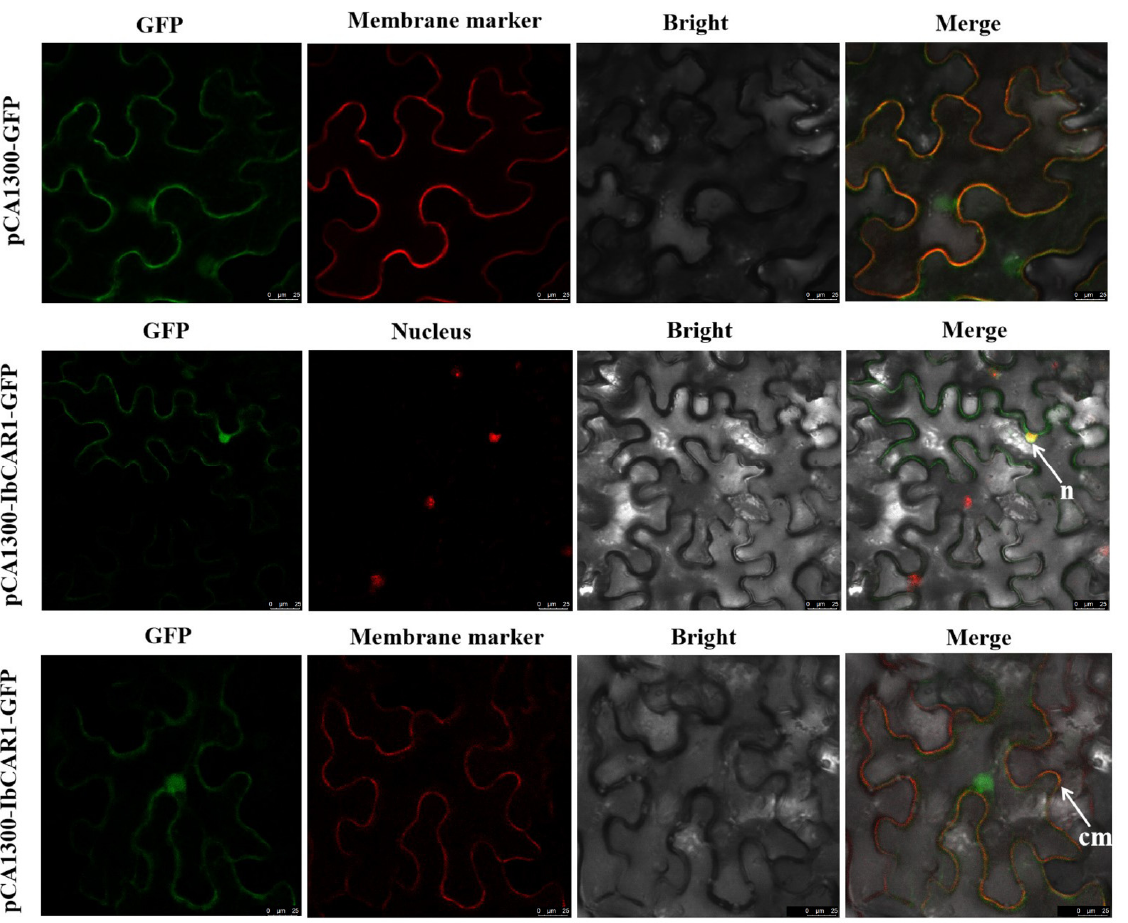
Figure 3. Subcellular localization of IbCAR1. OsMADS53 and AtSYP122 were used as nuclear and membrane markers, respectively. The n stands for nucleus. The cm stands for cytoplasmic mem ‐ brane. Confocal scanning microscopic images showed that the IbCAR1 ‐ GFP fusion expression pro ‐ tein localized on the nucleus and membrane. GFP as the control. Bars = 25 μ m.